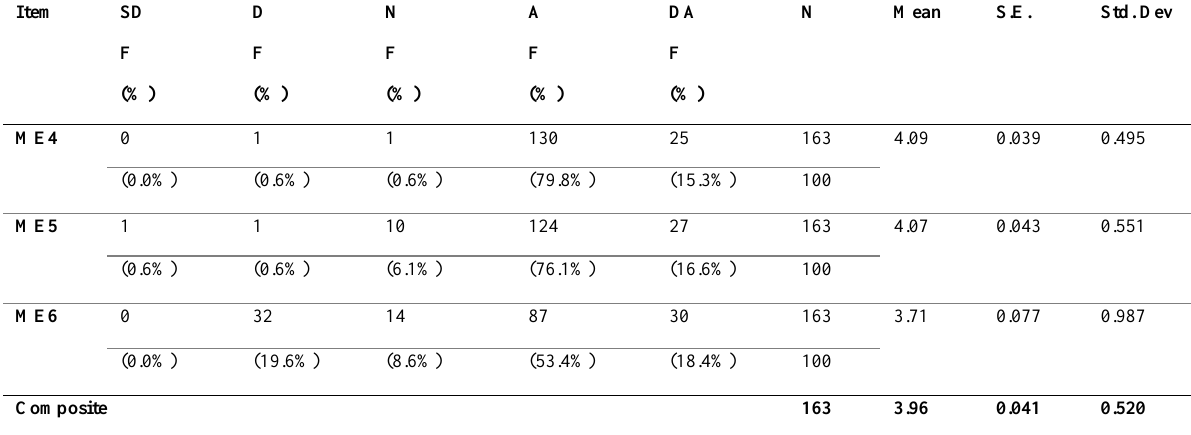
Table 2: Tools in Monitoring and evaluation and sustainability of